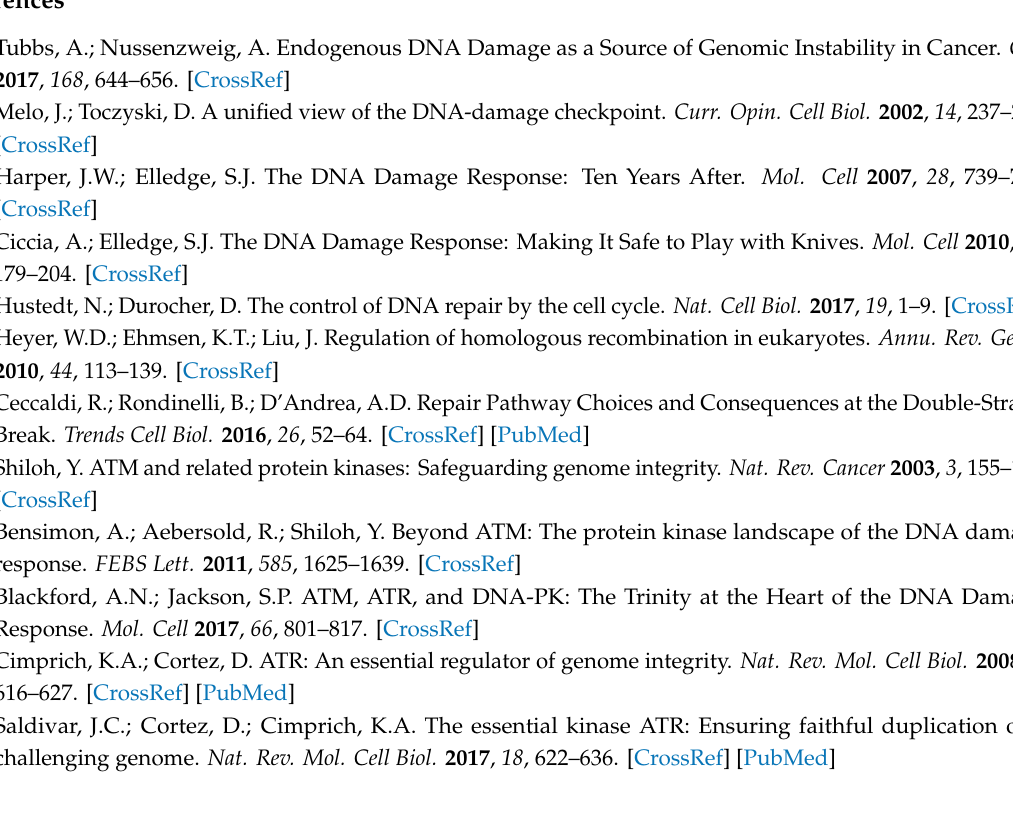
Figure S1: Molecular analysis of Ppatm and Ppatr mutants. Figure S2: Flow cytometric analysis of selected mutants. Figure S3: The P. patens life cycle. Figure S4: Supplemental growth analyses. Figure S5: Environmental conditions shape the Ppatm-1 , Ppatr-1 , and Ppatmatr-1 phenotypes. Figure S6: The mature gametophyte and reproductive structures. Table S1: Conservation of DNA damage repair-related genes between human, yeast, and A. thaliana and the corresponding gene set in P. patens . Table S2: The early response of DNA damage repair-related genes to bleomycin-induced DNA